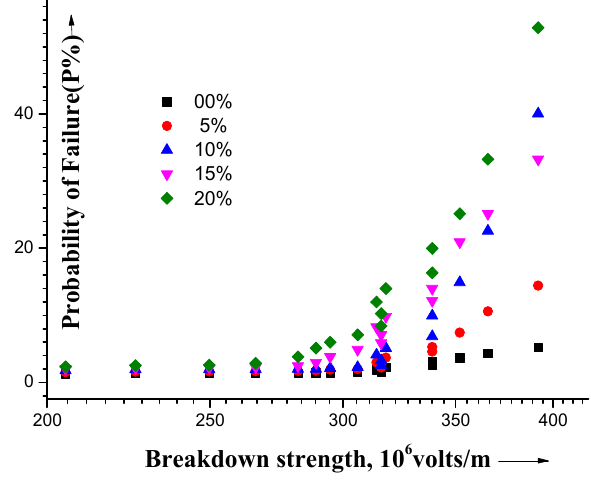
Figure 3. The probability of failure (P%) as a function of silica content for PS, P4VP, PI and PMMA.